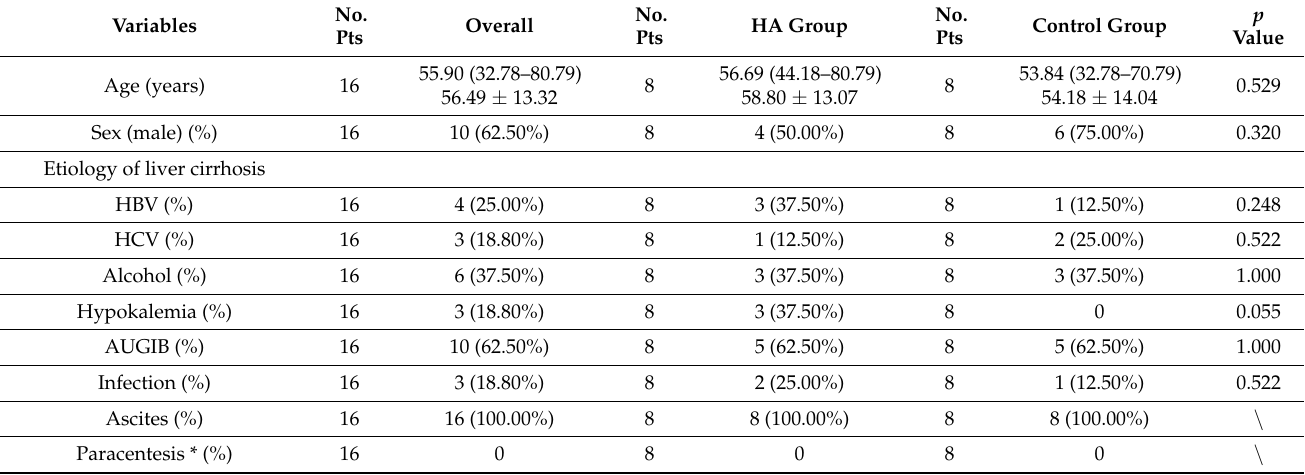
Table 4. Long-term outcome cohort—Characteristics of patients in the treatment study after PSM.